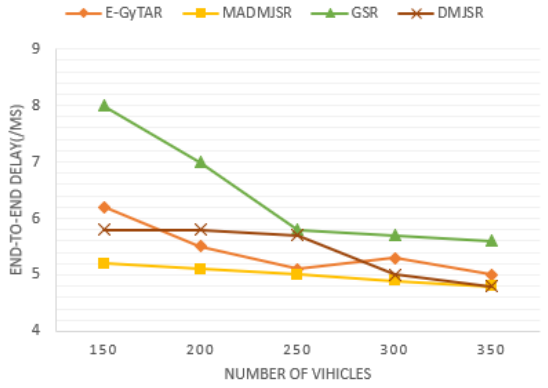
Figure 6. End-to-end delay on an increasing number of